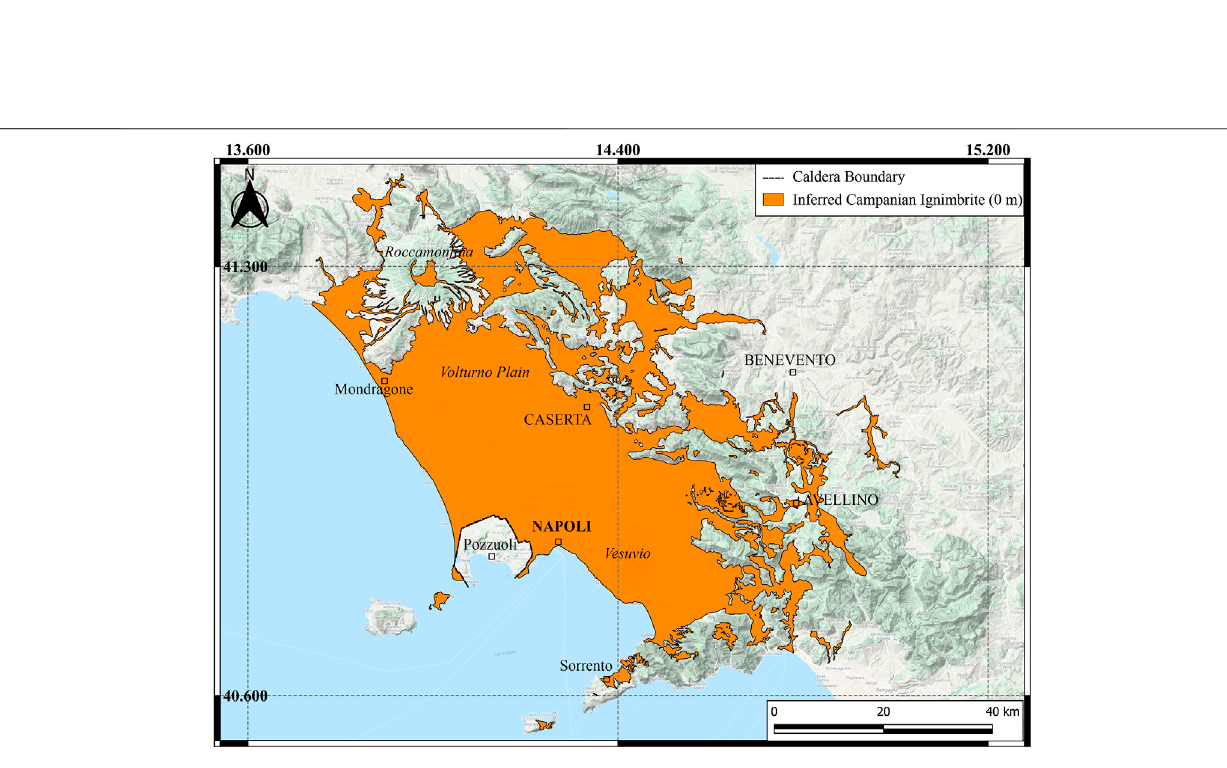
Frontiers in Earth Science |